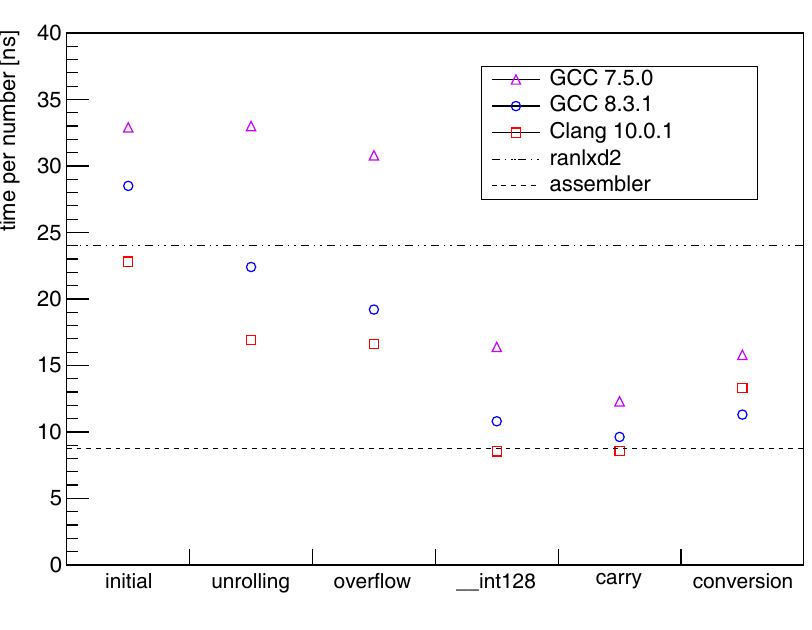
Figure 1. Performance results after each of the presented optimizations with di ff erent